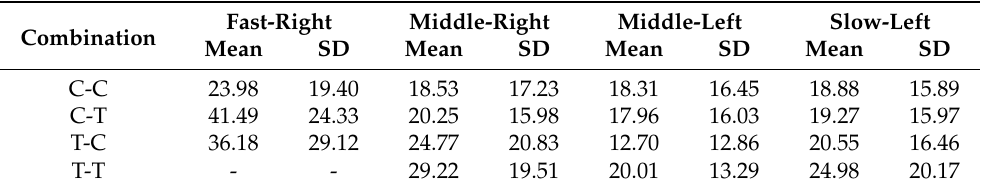
Table A8. The mean and standard deviation of TTC of m and n1.